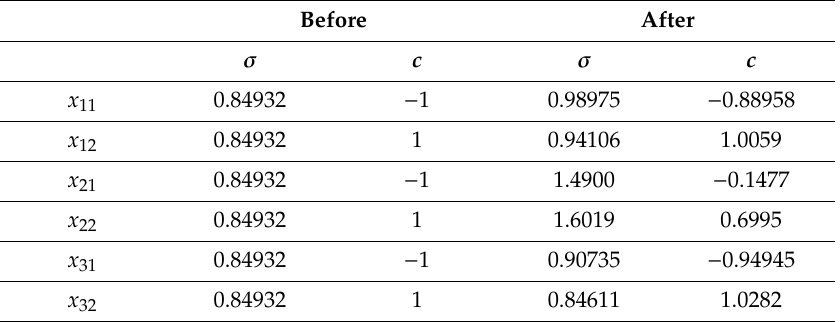
Table 6. Values obtained for the membership of function type 1 ( f 1 )